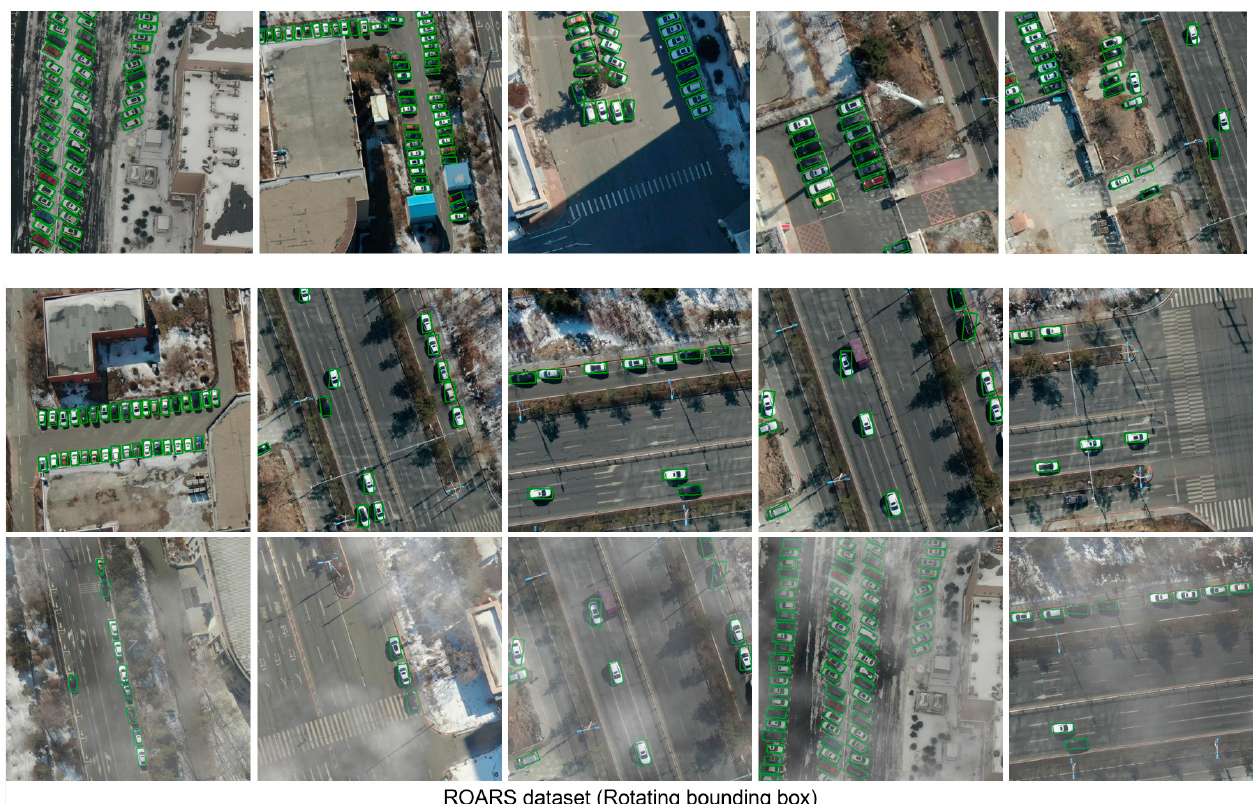
Figure 12. Results of SSRD-base detection methods in different datasets.